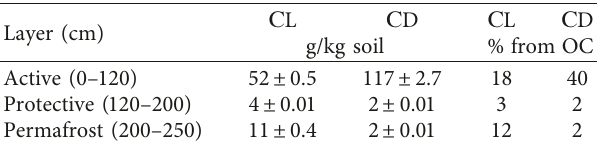
Table 3: The average labile carbon (CL) and carbon detritus (CD) content of soil organic matter for various fractions of the ice